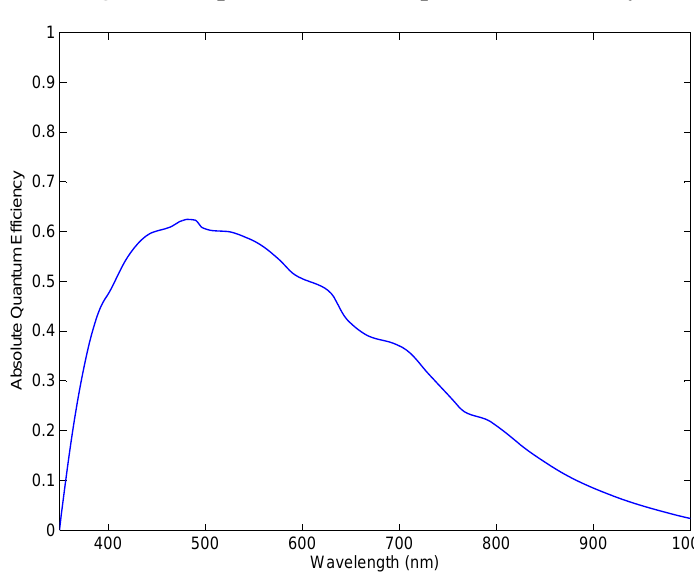
Figure 3. Aptina MT9P031 quantum